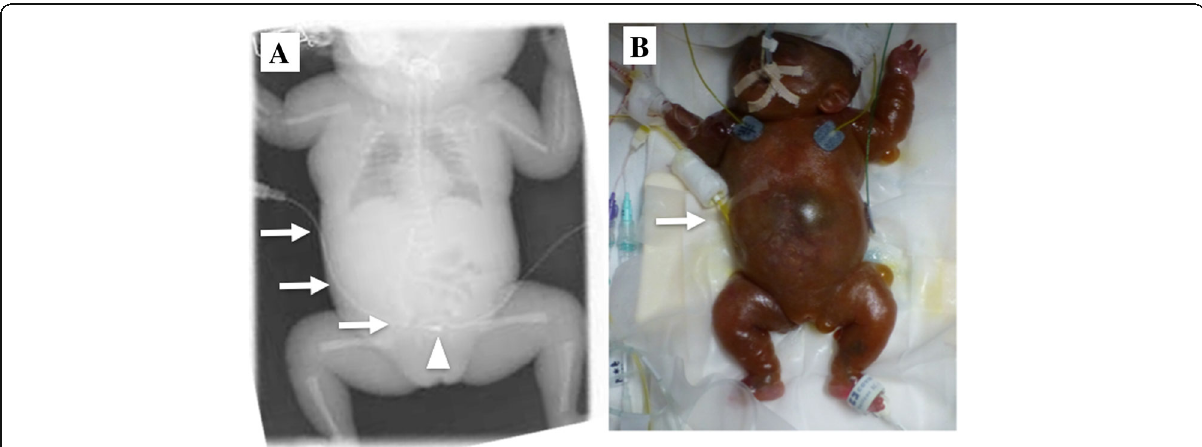
Fig. 1 a Abdominal X-ray of the patient on DOL 17. Arrows indicate the percutaneous drainage tube. The tip of the catheter was placed in the Douglas pouch (arrow head). b Photograph of the patient on DOL 21. PD was started by initially inserting a drainage tube. The arrow indicates the initially inserted drainage tube for peritoneal